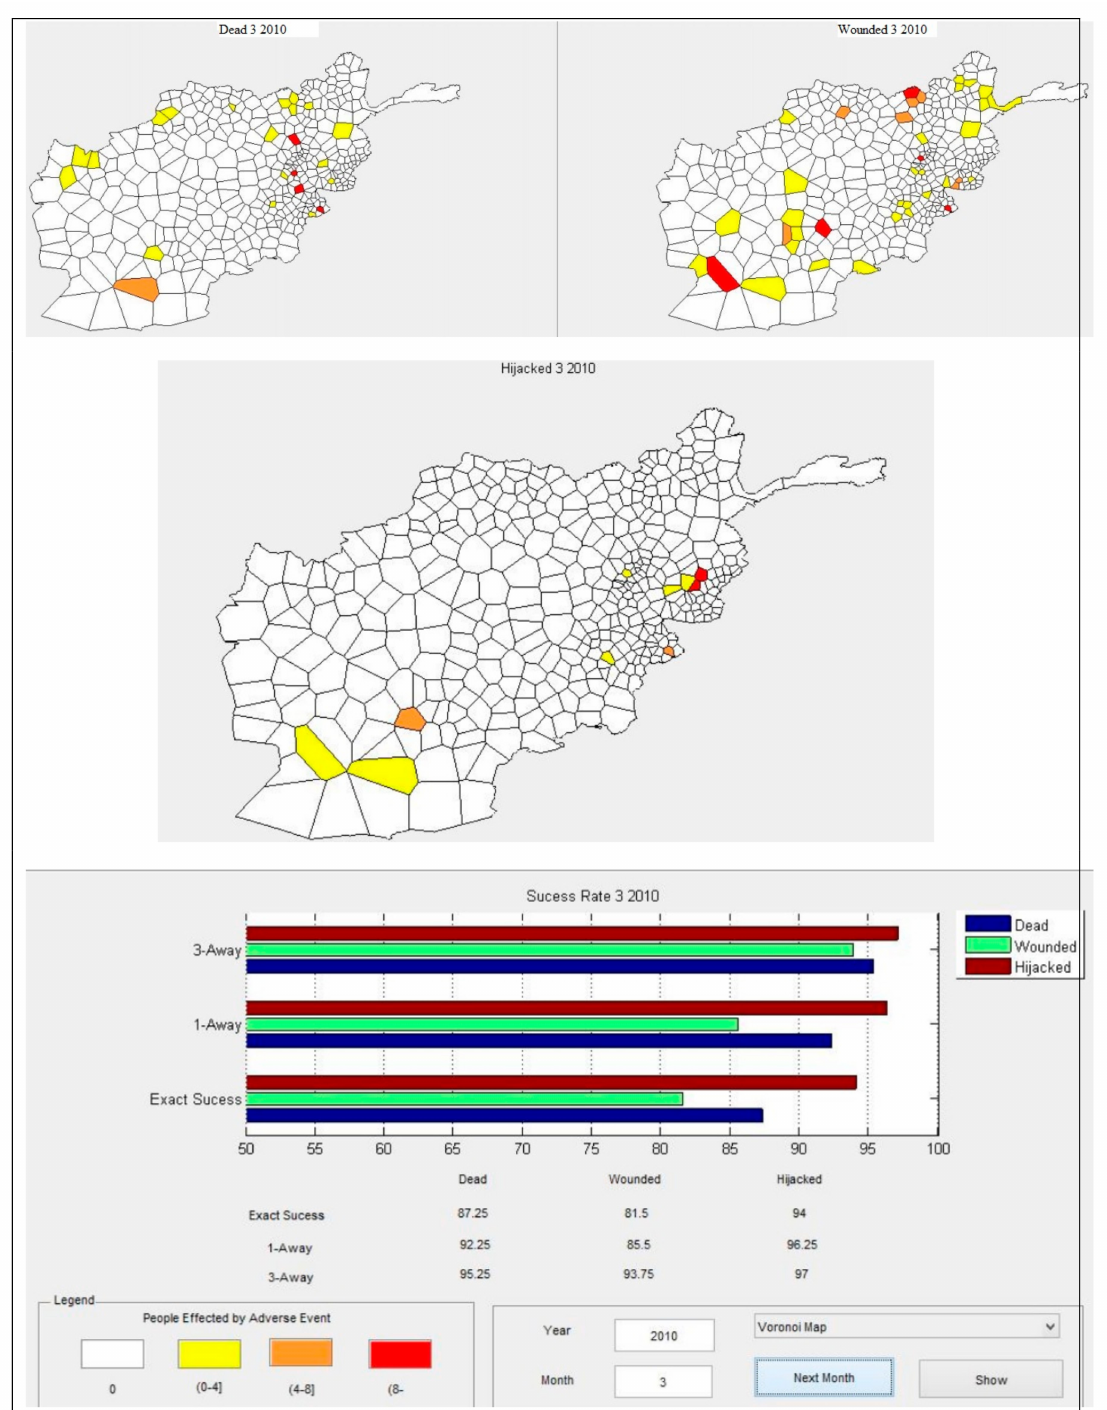
Figure 8. Security event predictions for March